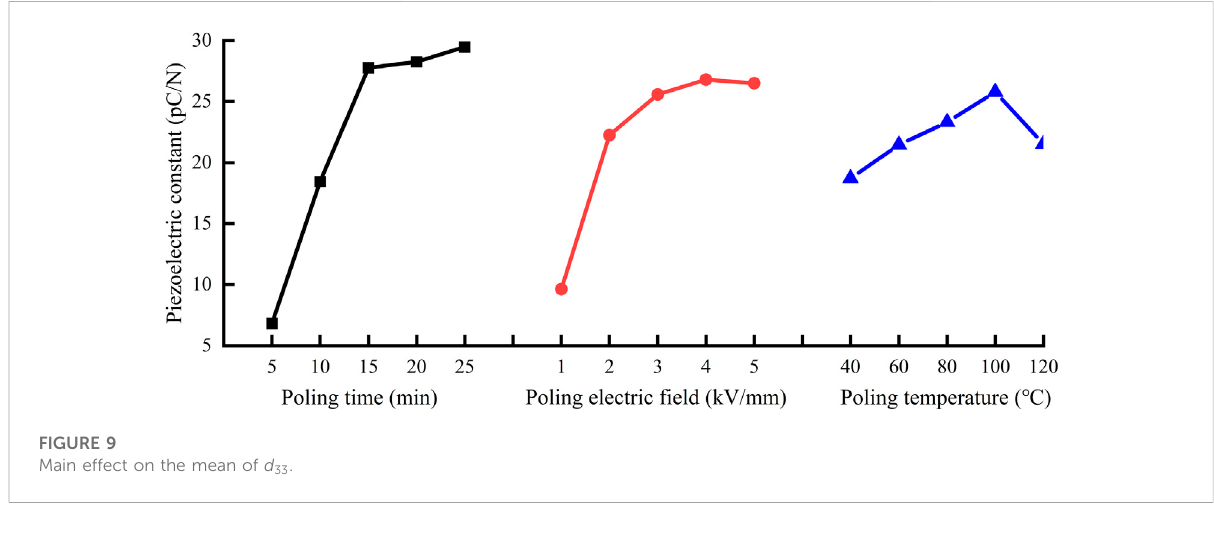
FIGURE 9 Main effect on the mean of d 33 .